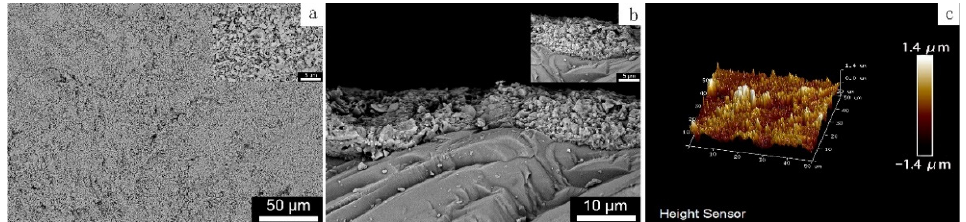
Figure 3. Morphology of treated samples. ( a ) SEM ‐ surface section, ( b ) SEM ‐ cross section, ( c ) AFM ‐ surface section.